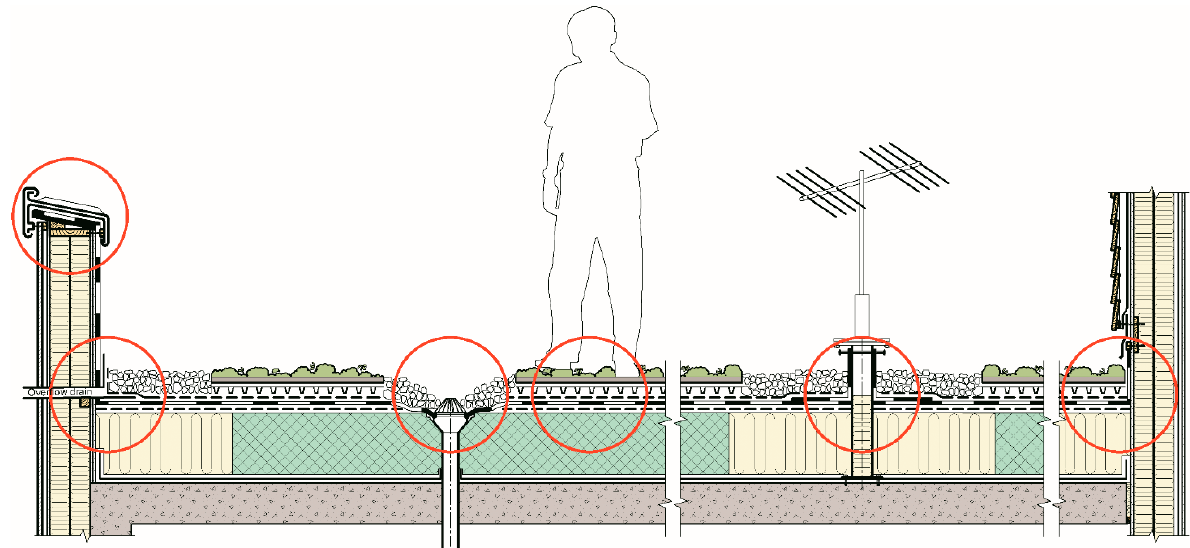
Figure 3. Overview of risk elements for green and blue-green roofs. Main details susceptible to defects are circled. They are, from left to right: flashings along the top of parapets, transitions between parapet and roof, drains, areas of high traffic, mounting systems for technical equipment, and transitions between the roof and adjoining walls, including doors.